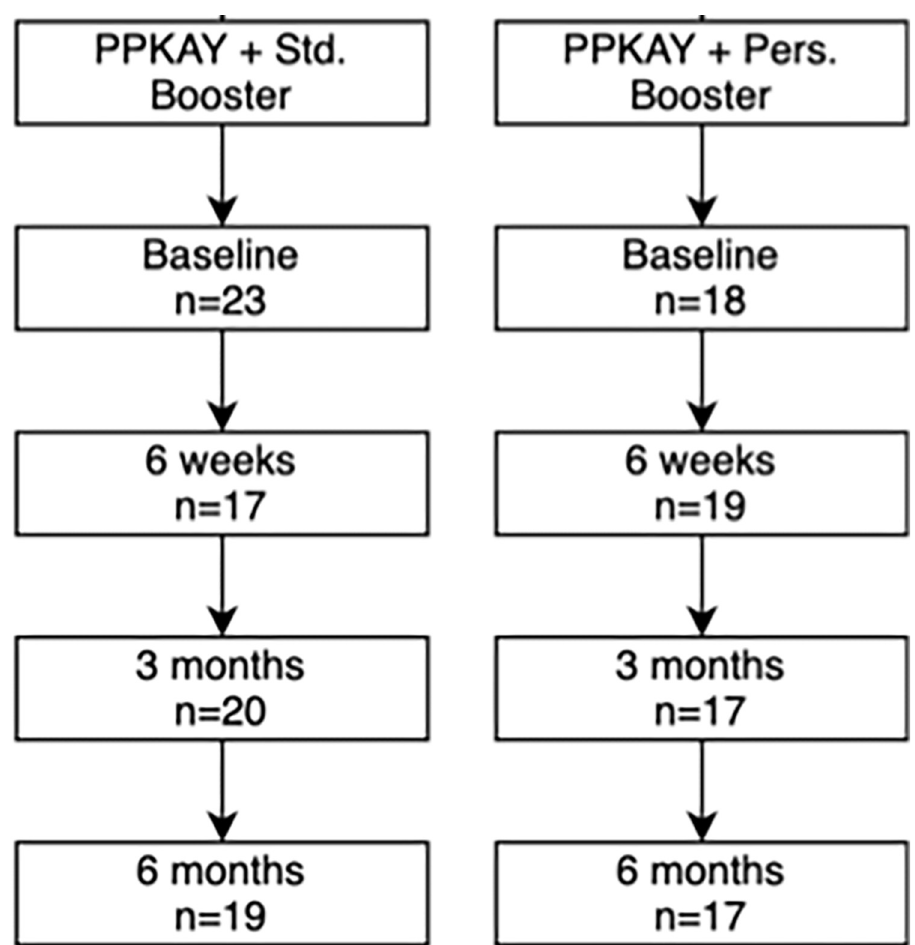
Fig 1. Eligibility, randomization, and retention flowchart for the two booster arms.